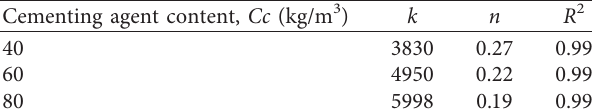
Table 3: Parameters k and n with varying cementing agent